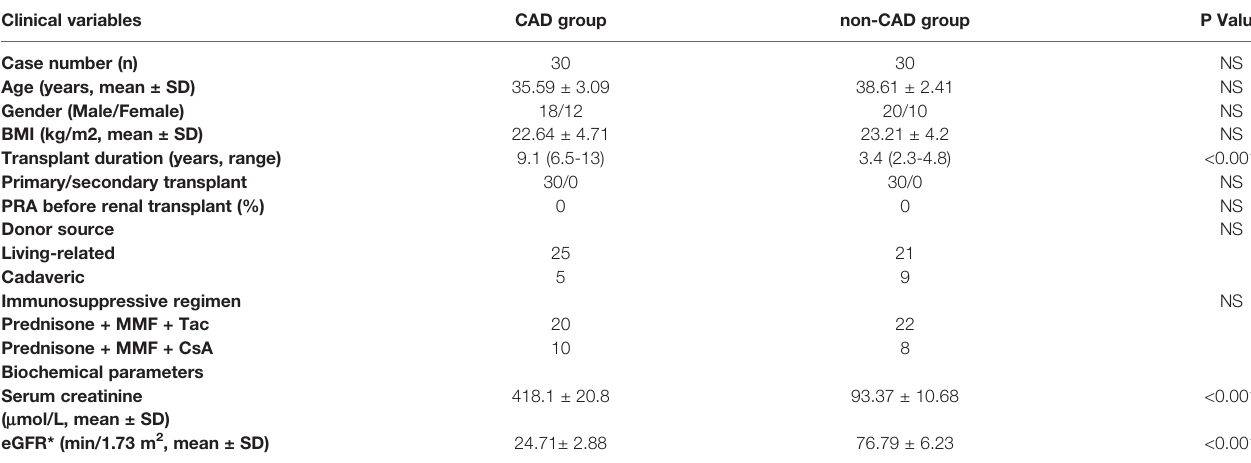
TABLE 1 | Baseline characteristics of the CAD and non-CAD groups. Clinical variables CAD